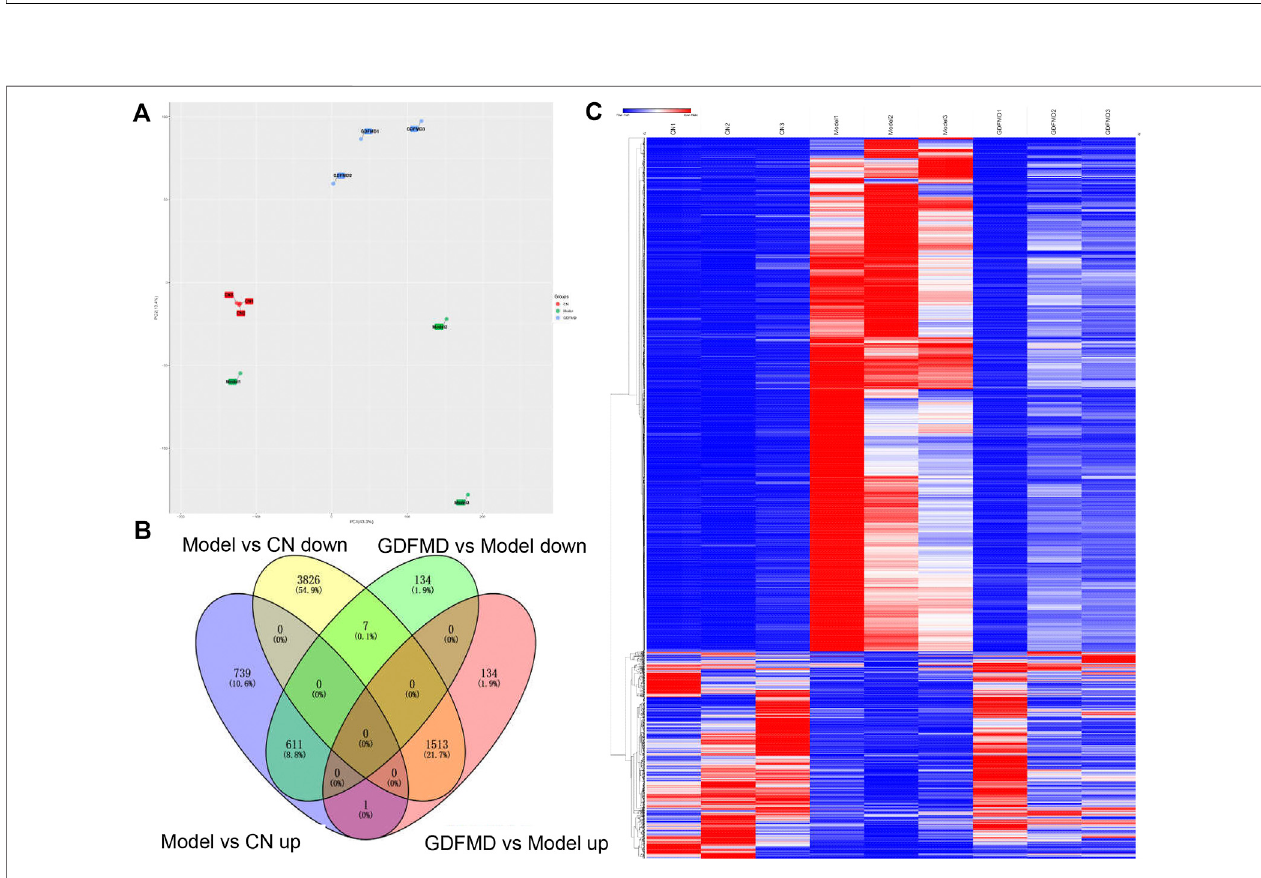
FIGURE2| BubbleplotsoftheGOenrichmentanalysisresultsusingClusterPro fi lerfordown-DEGs (A) anddown-DEGs (B) resultingforGDFMD-revisedwithWD.